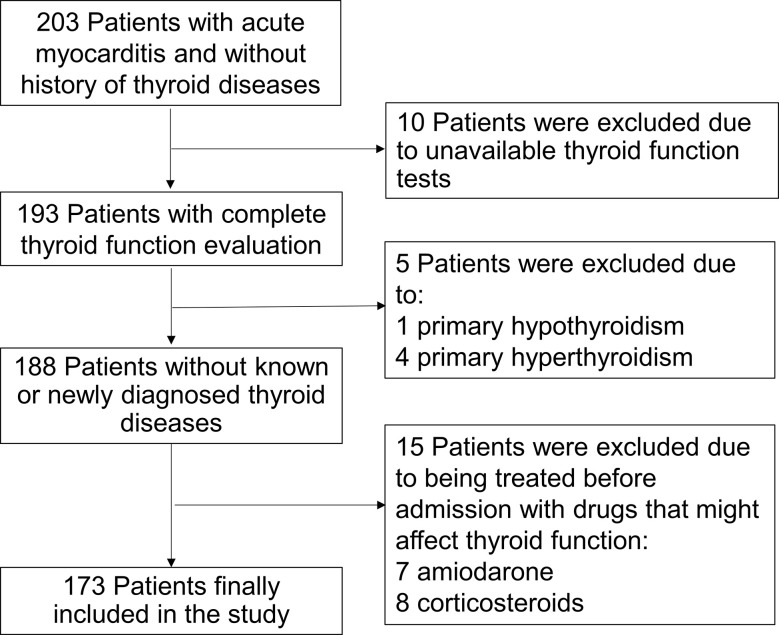
The flow chart of the enrollment of 173 adult patients with acute myocarditis from the overall population with acute myocarditis. 15 patients who had been treated before admission with drugs that might affect thyroid function were excluded.